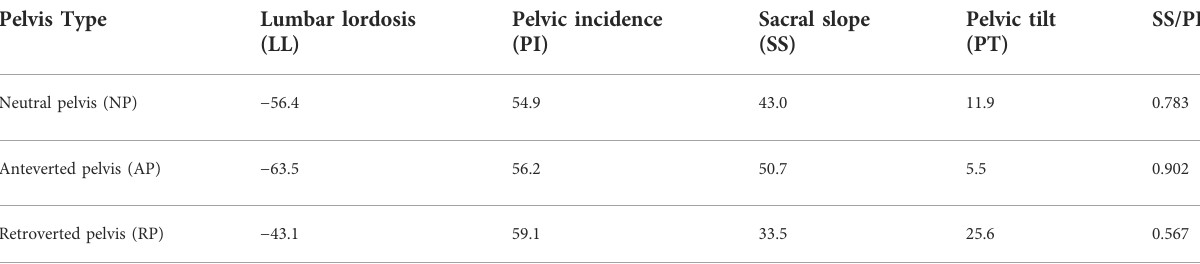
TABLE 1 Pelvic indicators for each representative model.